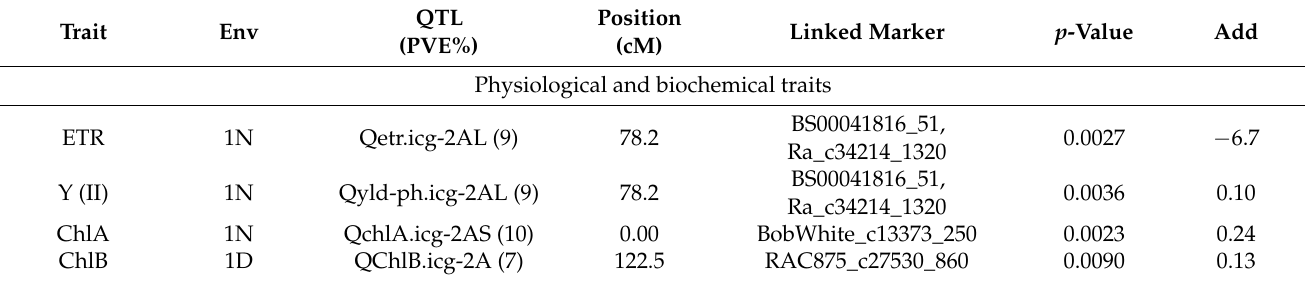
Table 3. The marker-trait associations (MTAs) detected on chromosome 2A in the set of RCSDH lines for physiological, biochemical, and agronomical traits under contrasting water regimes.